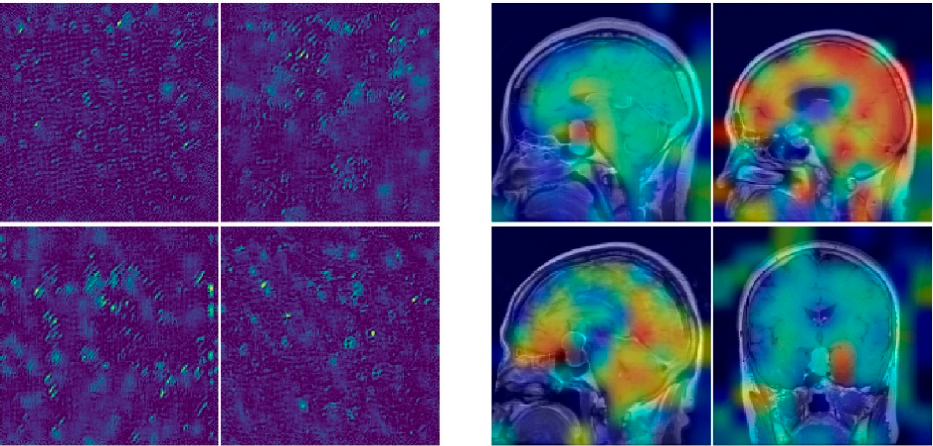
Figure 1. An Activation Maximization (on the left ) and Grad-CAM visualization (on the right ) examples of a CNN trained to classify brain tumors.